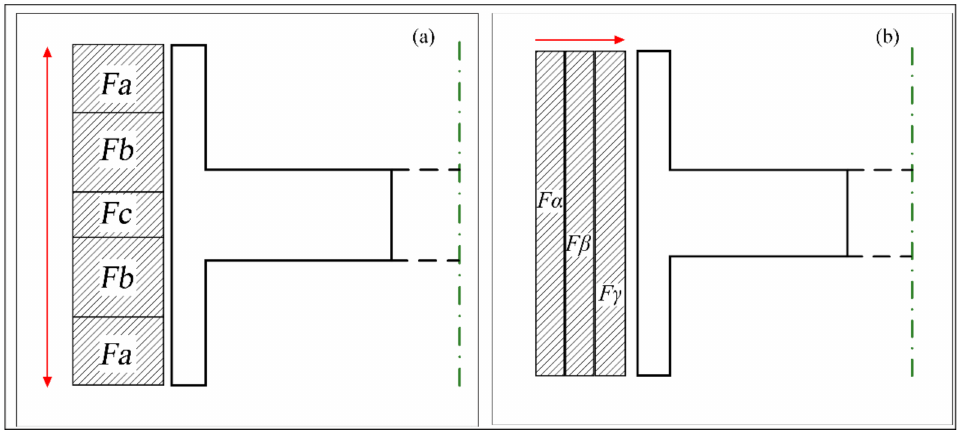
Figure 8. Winding tension distribution diagram: ( a ) IPWVT and ( b )